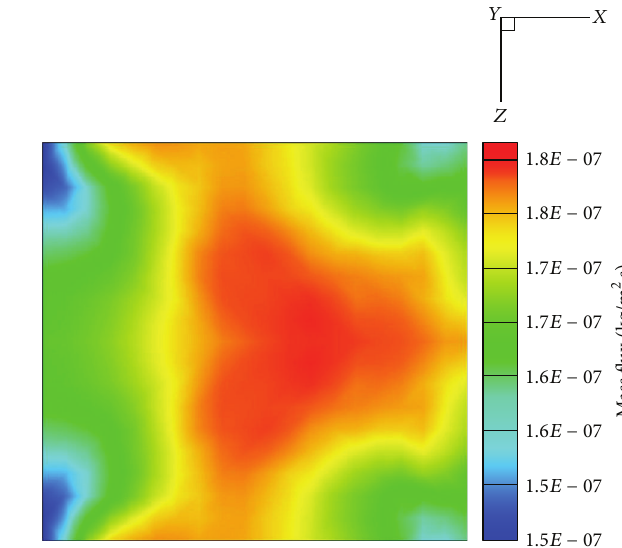
Effect of gap distance (source diameter 200 mm)